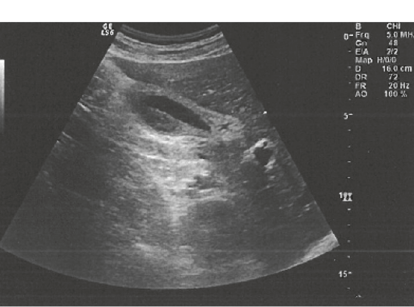
Figure 2: Abdominal ultrasound showing pericholecystic fluid collection, large free fluid at Douglas’s pouch, and right paracolic